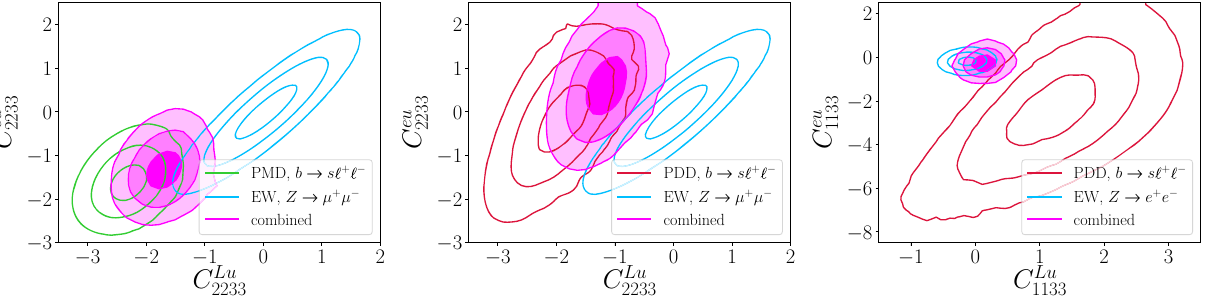
, C eu ) in both surements [207] are shown in light blue. The resulting region obtained (cid:2)(cid:2) 33 33 from the combined information of EW and b → s (cid:2) + (cid:2) − data is high- lighted in fuchsia